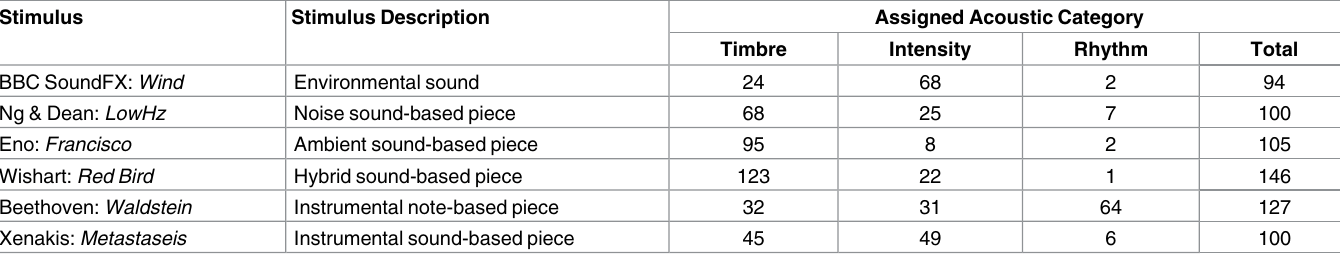
Table 1. Number of perceived phrases assigned to intensity, timbre, or rhythm categories.